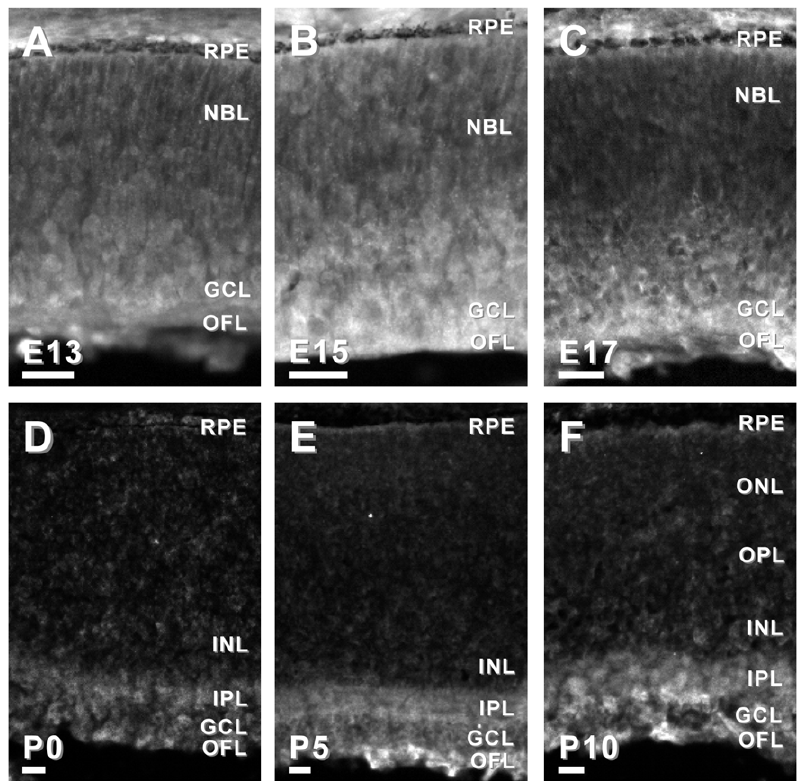
Figure 6. Dynamic protein expression of TSMB10 in developing mouse retina. TSMB10-IR in the E13 and E15 mouse retina was distributed throughout the retina (A, B). In the E17 mouse retina, TSMB10-IR was more intense in the inner one-third of the retina (C). By P0 TSMB10-IR in the mouse retina was largely restricted to the IPL, GCL and OFL (D). Similarly in the P5 and P10 retinas, TSMB10-IR was observed in the IPL, GCL and OFL (E, F). Abbreviations same as in Figure 2. Bars, 30 m